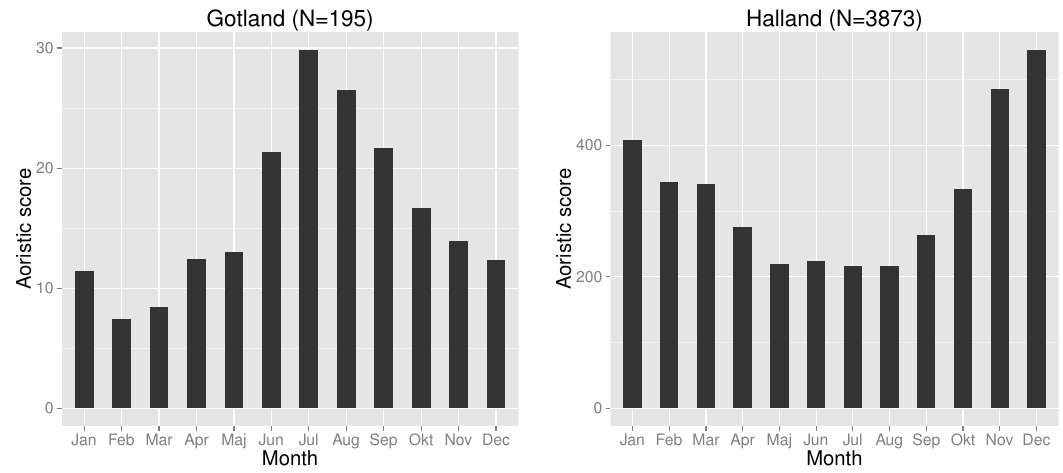
Figure 9. Aoristic crime frequency distribution per month based on five years’ worth of residential burglaries in two different counties in